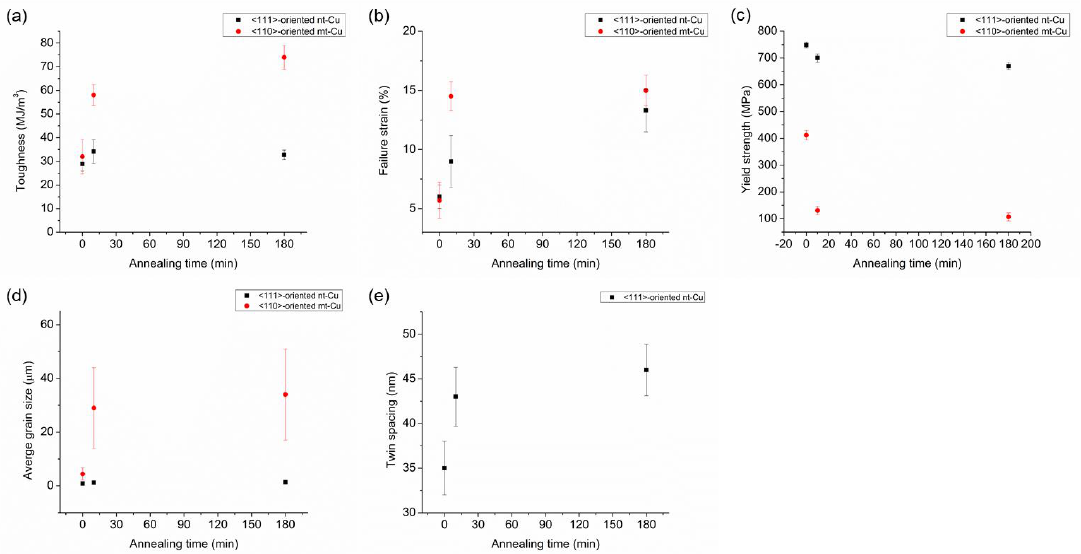
Figure 8. The ( a ) toughness, ( b ) failure strain, ( c ) yield strength, and ( d ) average grain size of <110>-oriented mt-Cu and <111>-oriented nt-Cu before and after annealing at 250 °C for 10 and 180 min. ( e ) The average twin spacing of <111>-oriented nt-Cu.